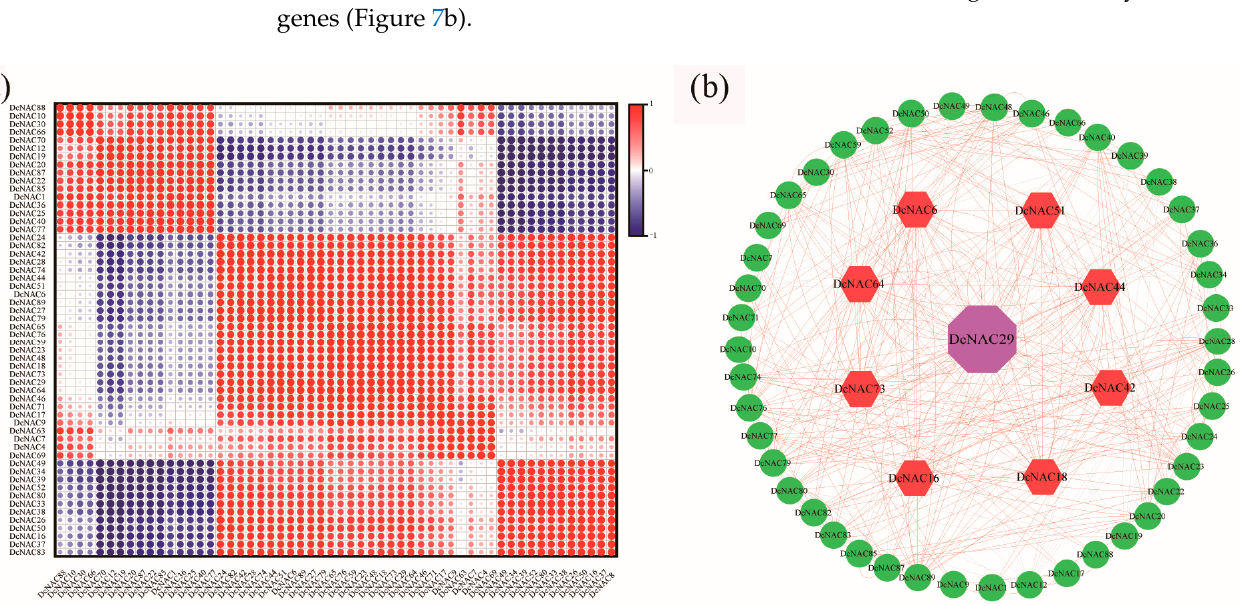
Figure 6. The expression patterns of DcNAC genes evaluated by RNA-seq. The left heatmap shows the expression of DcNAC genes under different volumetric water contents of base material. Data were normalized relative to each gene’s mean expression value across all treatments and log2-trans- formed. TPM (transcripts per million) values were used to create a heat map showing the expression of DcNAC genes. The expression level ranged from low expression (green) to high expression (red). The right heatmap showed the TPM ratios, with high ratios in red and low ratios in cyan. T1 was equal to the TPM of 10–15% divided by the TPM of 30–35%, and T2 was equal to the TPM of 0% divided by the TPM of 30–35%. The amounts of 30–35%/10–15%/0% represent the fact that the vol-